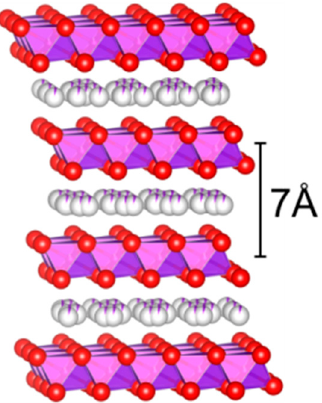
Figure 1. The layered structure of the investigated birnessite phase. The red spheres represent oxygen ions in the corners of the purple MnO 6 octahedral units, while the white spheres denote the potential positions available for interlayer cations or molecules.